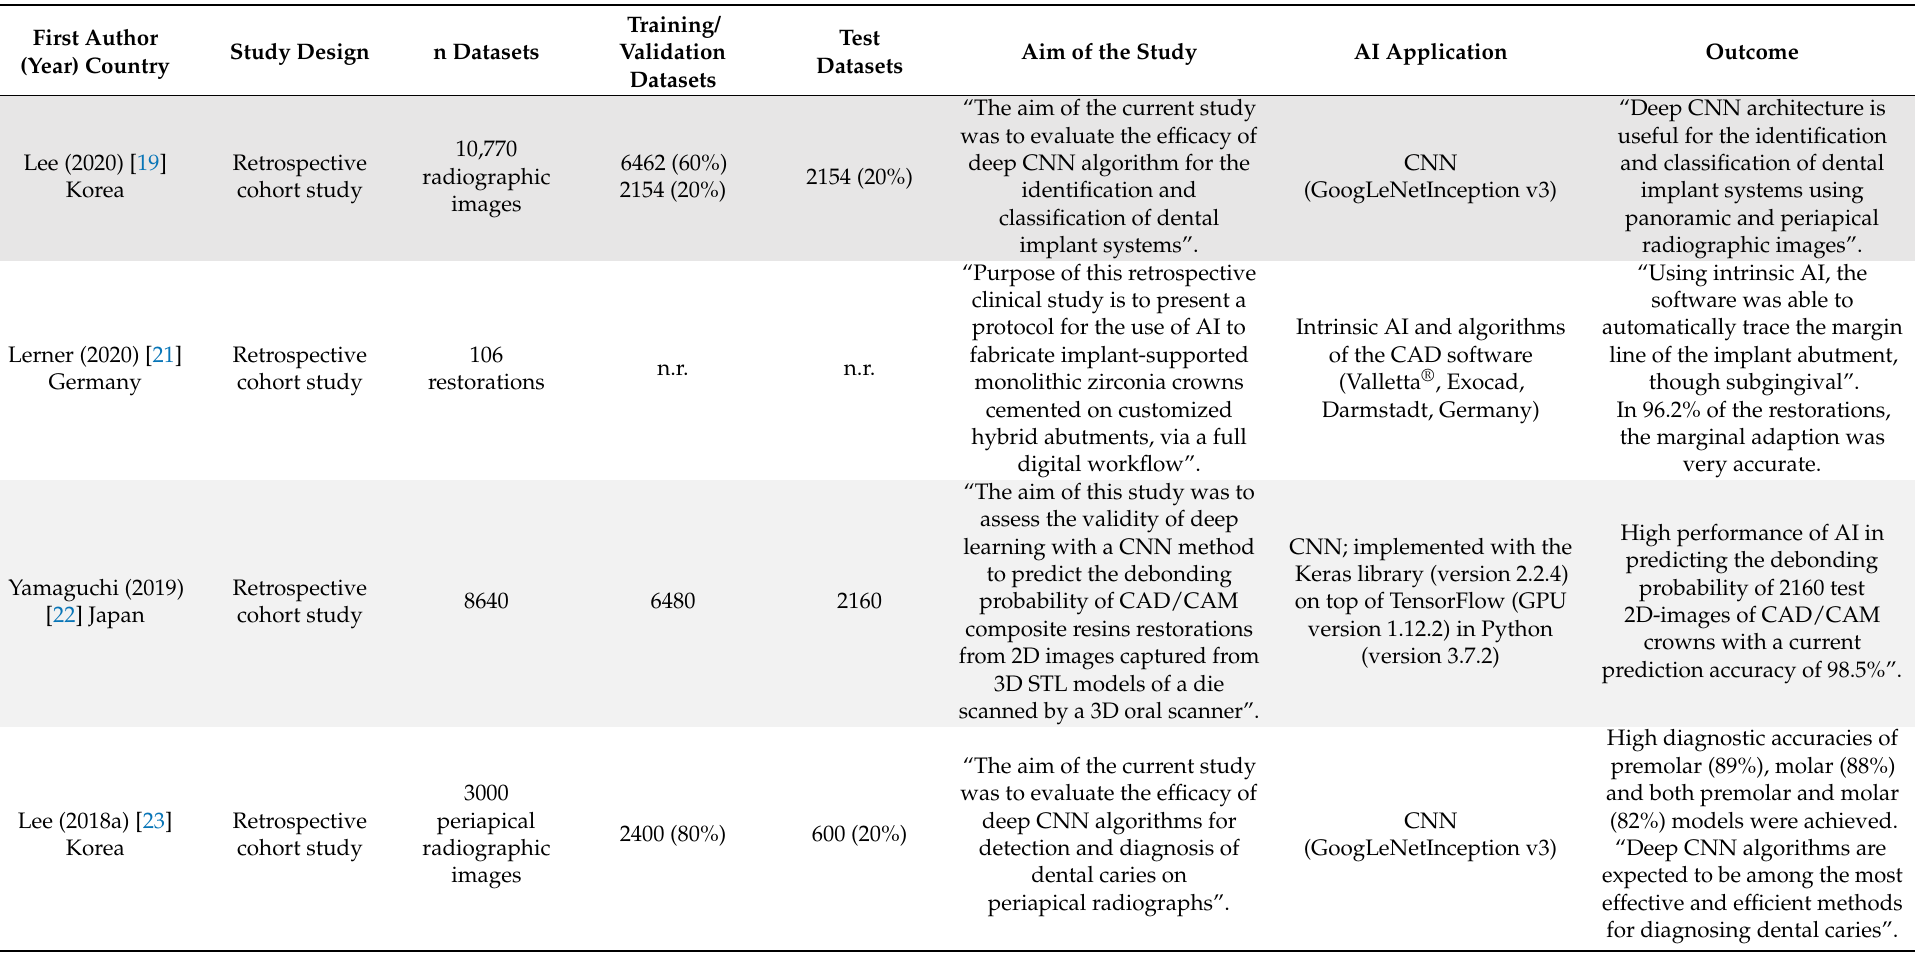
Table 3. Characteristics and outcomes of the studies